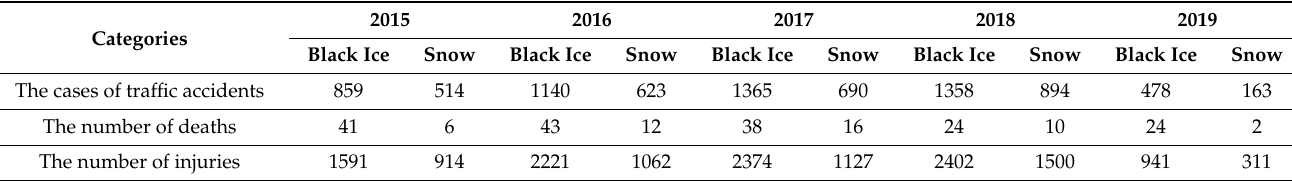
Table 2. Traffic accident statistics by road